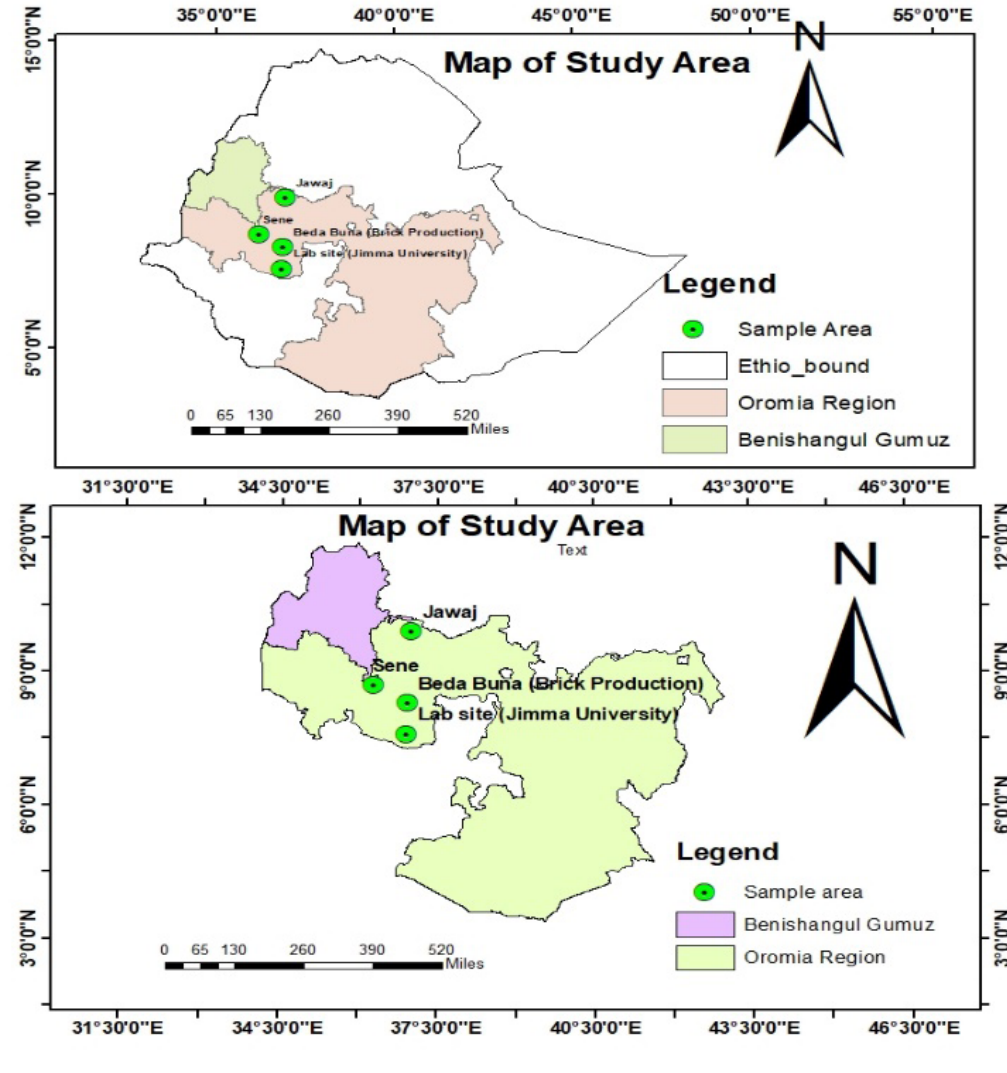
Figure 1: Point locations of Sene and Jawaj sampling sites.